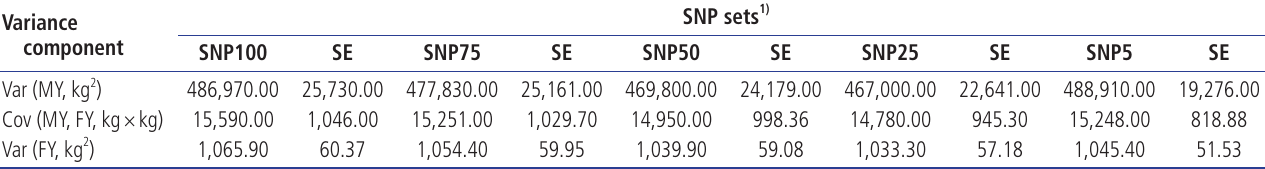
Table 3. Environmental variances and covariances for MY and FY estimated with five SNP sets using genomic-polygenic models Variance component